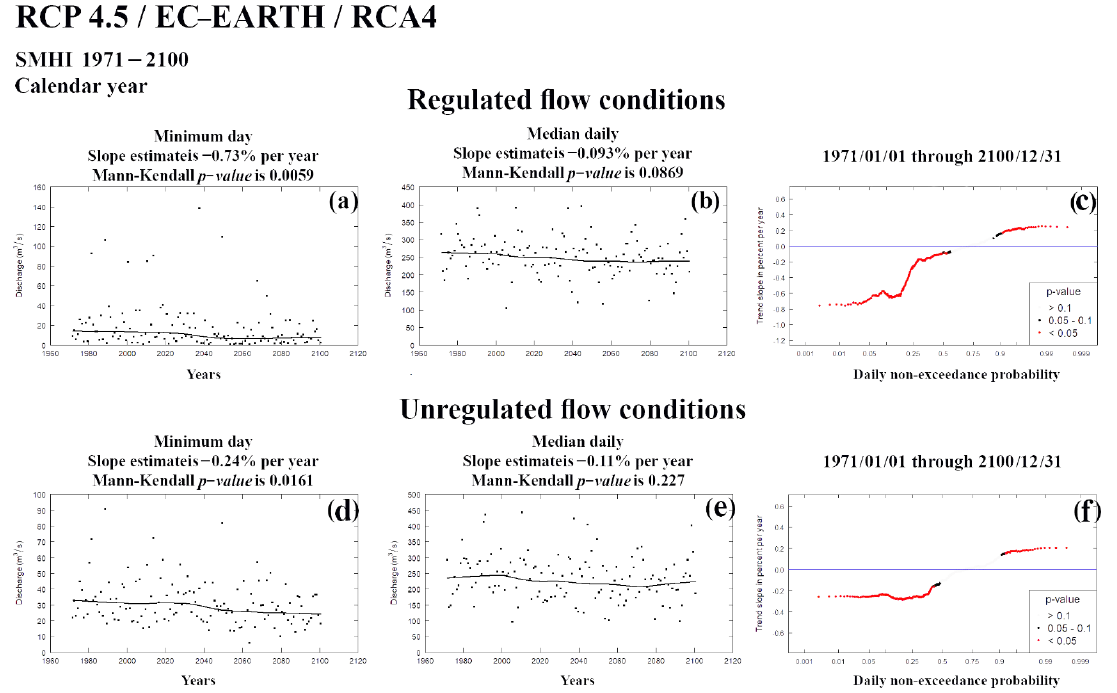
Figure 6. FlowTrend plots from the combination RCP4.5/EC − EARTH/RCA4 for annual simulated daily streamflow for regulated conditions: ( a ) minimum day; ( b ) median day; ( c ) Quantile − Kendall plot, and for unregulated conditions: ( d ) minimum day; ( e ) median day; ( f ) Quantile − Kendall plot.